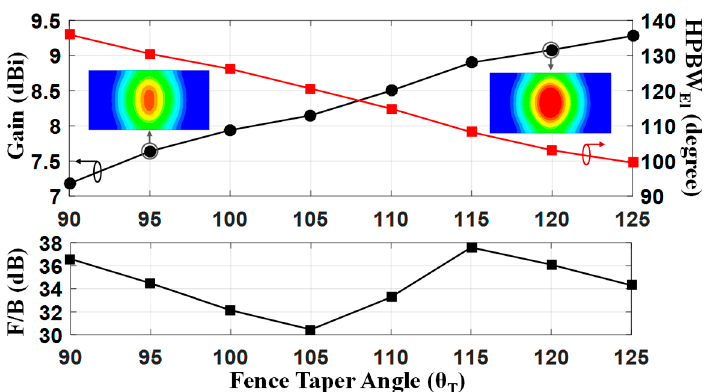
Figure 3. The simulated gain, HPBW El , and F / B versus the V-fence taper angle at 28 GHz, and the